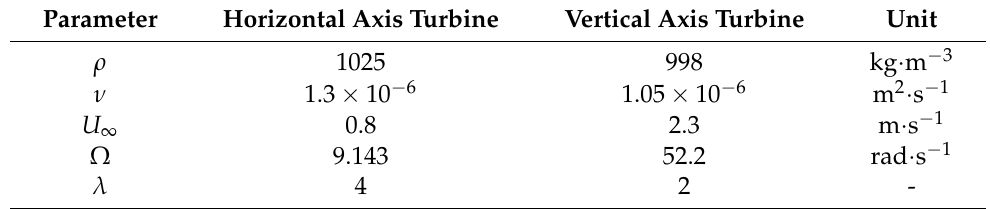
Table 4. Table of the physical parameters used in simulations for horizontal and vertical axis cases.